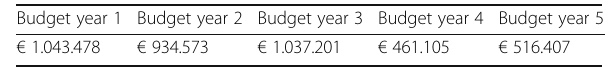
Table 5 Yearly budget for solution